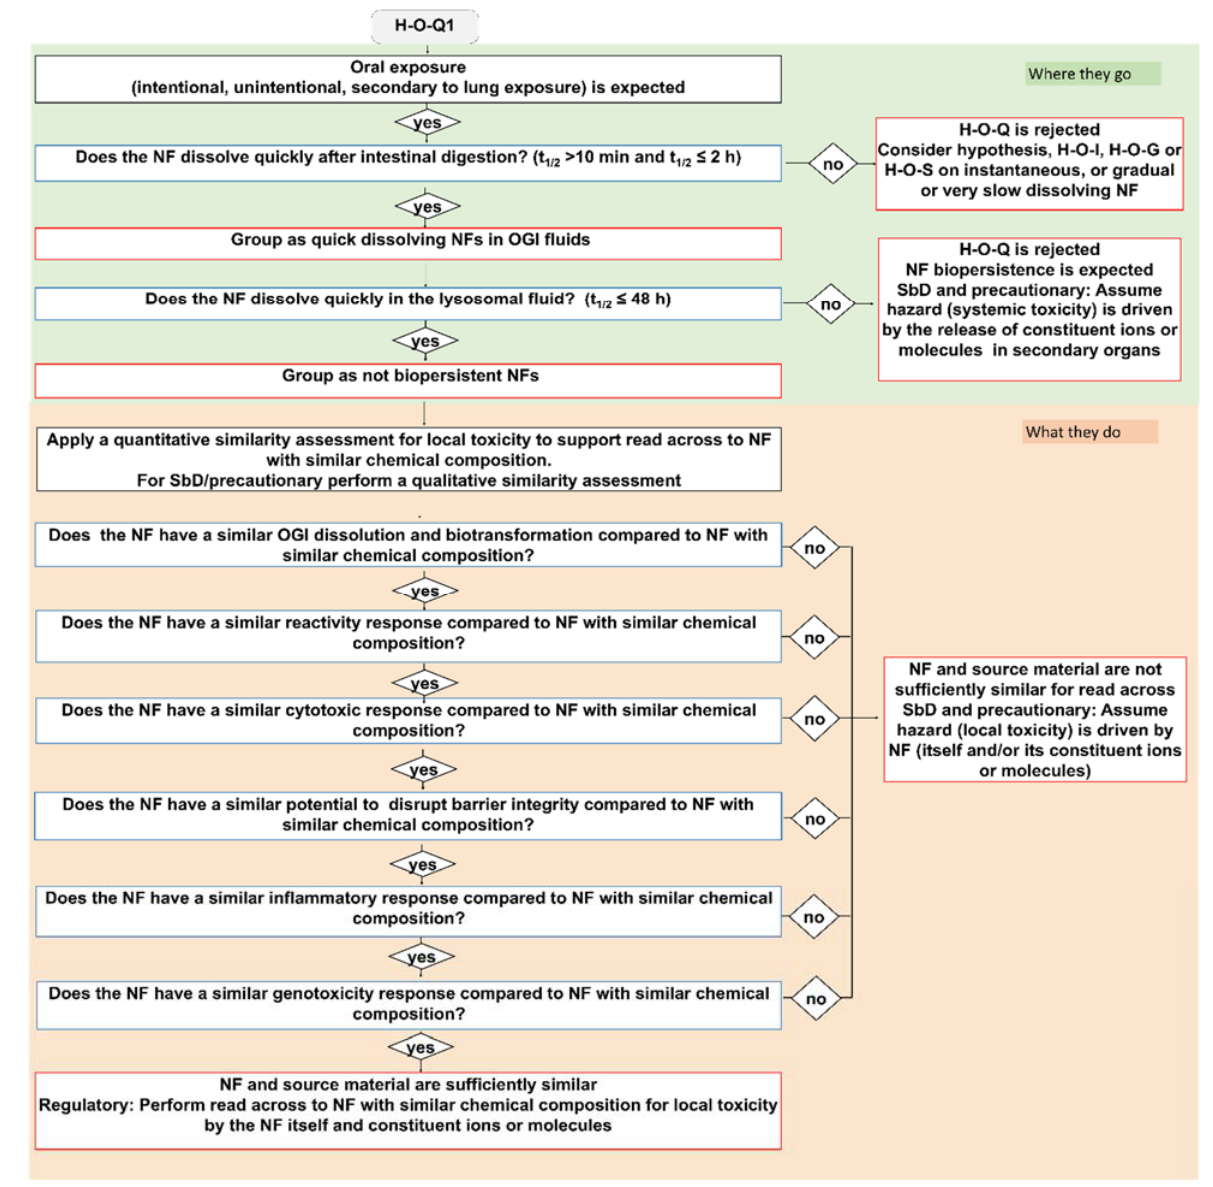
Figure 2. The IATA which addresses the oral ingestion hypothesis H ‐ O ‐ Q1: Following oral exposure, both NFs and con ‐ stituent ions or molecules may contribute to local inflammation in the OGI tract, but there is no concern for NF accumu ‐ lation. Blue bordered boxes are decision nodes, red bordered boxes are hypothesis conclusions, black bordered boxes are considerations.